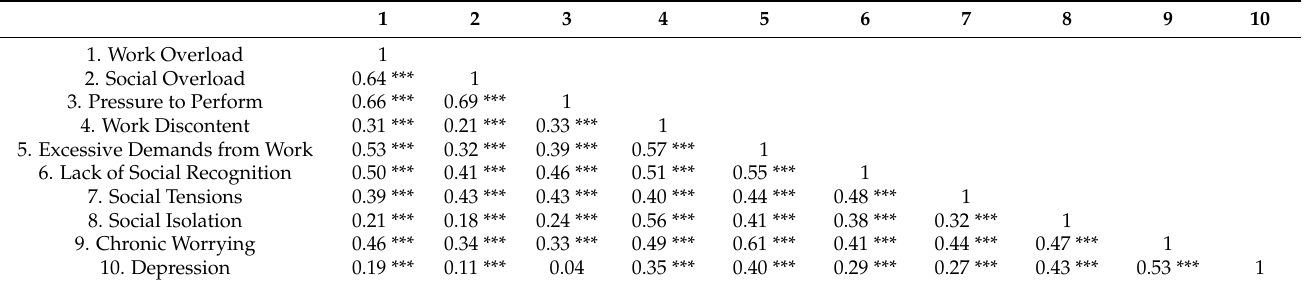
Table 2. Correlations between areas of chronic stress and depression (N =